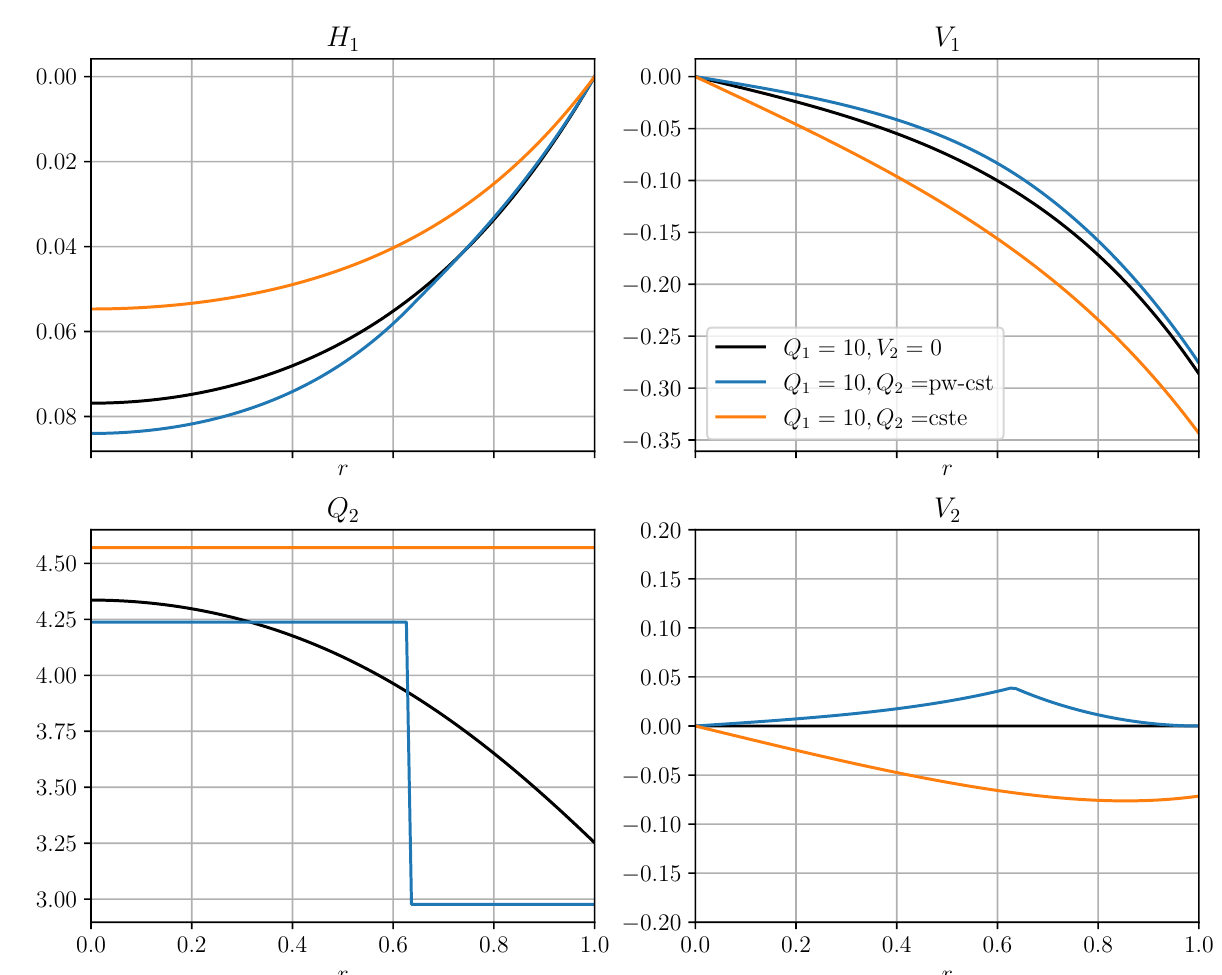
Figure 10. Vortex profiles (same fields as Figure 1) with different lower-layer conditions: quiescent ( V 2 = 0; black), piecewise-constant PV (blue) and constant PV (orange). Vortex parameters: Q 1 = 10, δ =